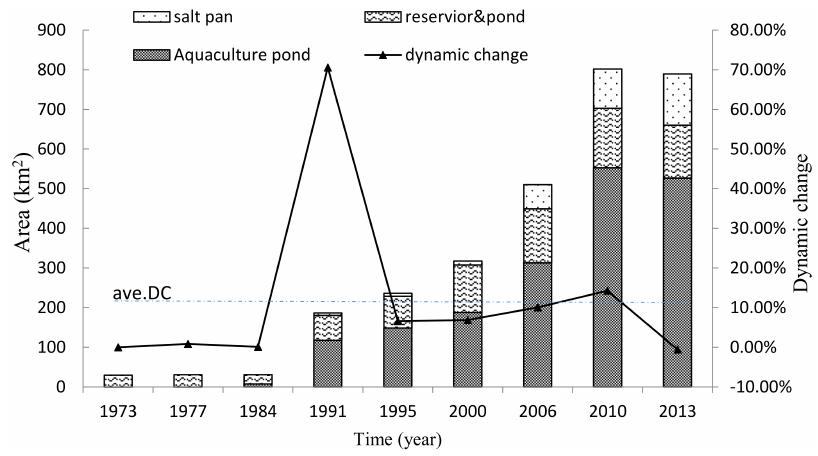
Figure 8. Accumulation histogram of artificial wetland area and dynamic change. The blue line is the average dynamic change (ave. DC). Water 2018 , 10 , x FOR PEER REVIEW